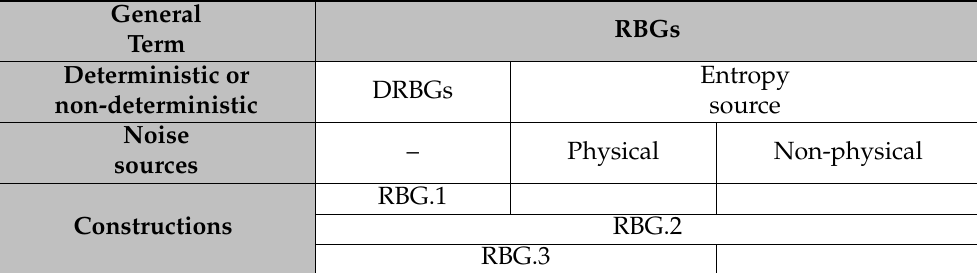
Table 1. Nomenclature and taxonomy for RBGs put out by the NIST standardisation organ- isation.